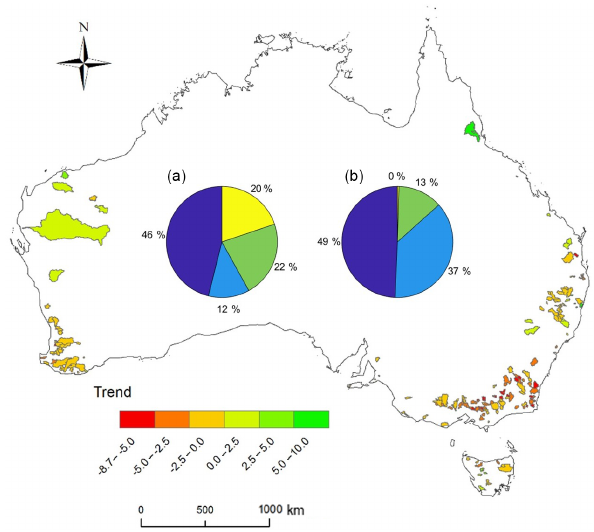
Figure 2. Trends and streamflow data summary for the 217 catch- ments used in this study. The trend in annual streamflow is shown in units of mmyear − 1 year − 1 . The chart in (a) indicates the catch- ment percentage with different missing data rates (dark blue with a missing data rate of 0%, navy blue with a missing data rate of 0%–0.1%, green with a missing data rate of 0.1%–0.5%, and yellow with a missing data rate of 0.5%–1.0%). The chart in (b) indicates the catchment percentage with different trends (dark blue with a significant ( p ≤ 0 . 05) decreasing trend, navy blue with a non-significant ( p > 0 . 05) decreasing trend, green with a non- significant ( p > 0 . 05) increasing trend, and yellow with a signifi- cant ( p ≤ 0 . 05) increasing